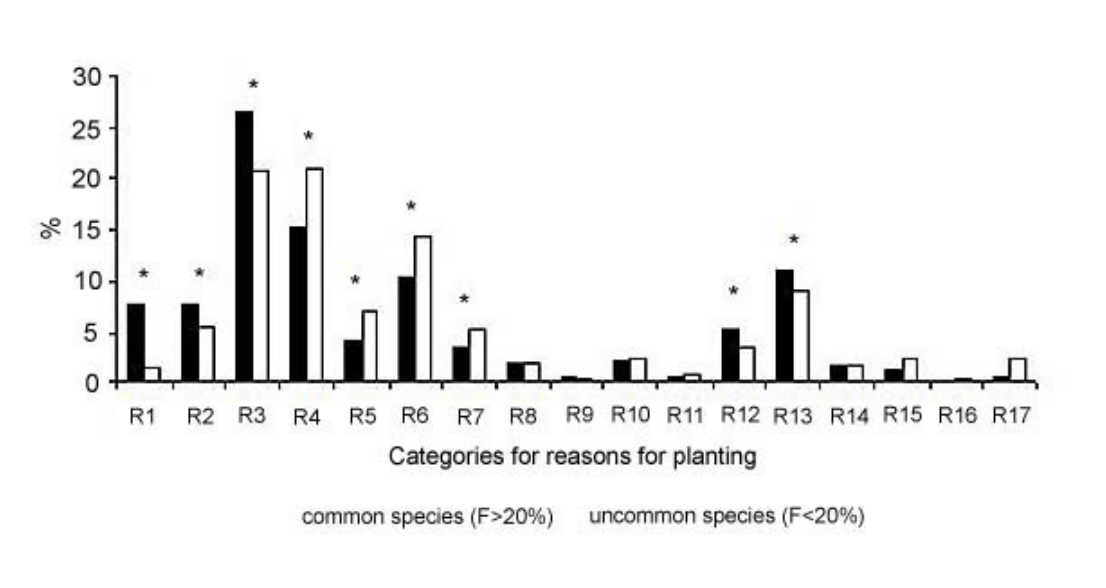
Fig. 4. Frequency distribution of categories for reasons given for planting of cultivated species by common (in black) and uncommon (in white) species. R1: regional character; R2: resistance-adaptation; R3: esthetics; R4: donation-gift; R5: professional advice; R6: use; R7: propagation; R8: easy maintenance; R9: symbolism; R10: imitation; R11: remembrance; R12: specific flowering; R13: previous presence in garden; R14: past experimentation; R15: change; R16: usefulness for another plant; R17: other. * 95% confidence